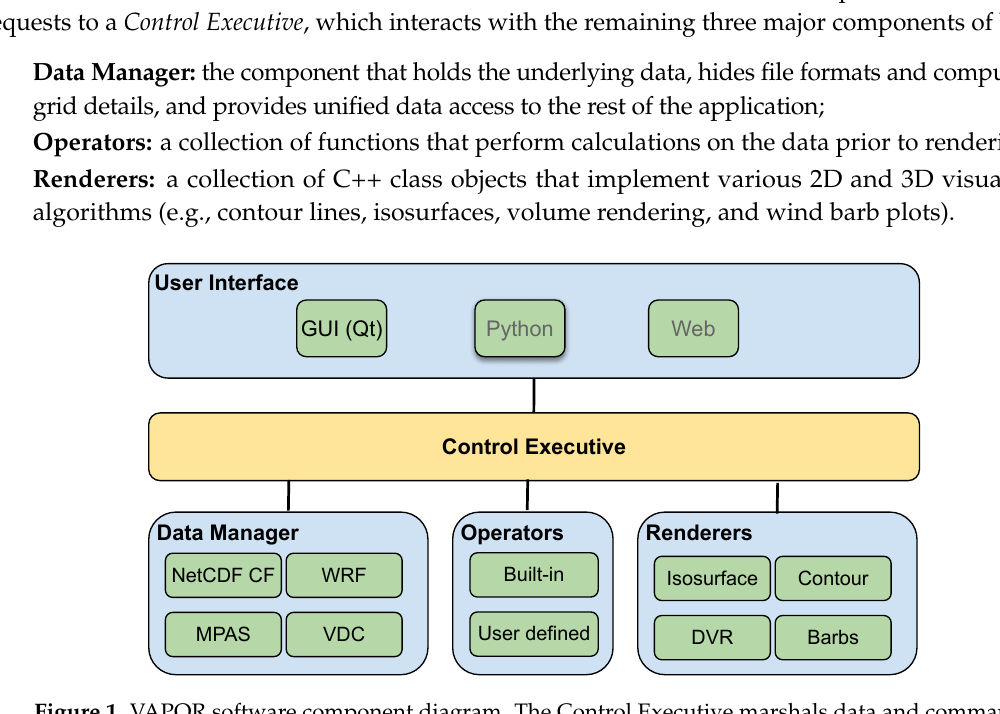
Figure 1. VAPOR software component diagram. The Control Executive marshals data and commands between the User Interface, and the other three primary components: Data Manager, Operators, and Renderers. The components in gray (Python and web) are still yet to be